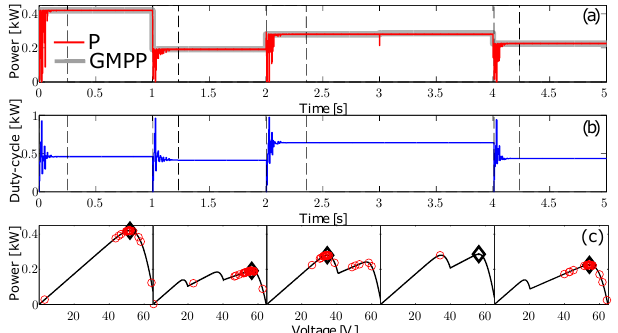
Figure 10. Simulation results for different transient events considering n = 5 , w = 0 . 2 , C and C . (a) 1 = 1 . 6 2 = 1 . 6 Produced power (b) Duty cycle. (c) P-V pattern adopted in each time interval. The colors blue, red were used respectively for the instantaneous duty-cycle and power and the gray for the theoretical GMPP. In (c) the diamond-shaped marks indicate the GMPP and the red circles the particle